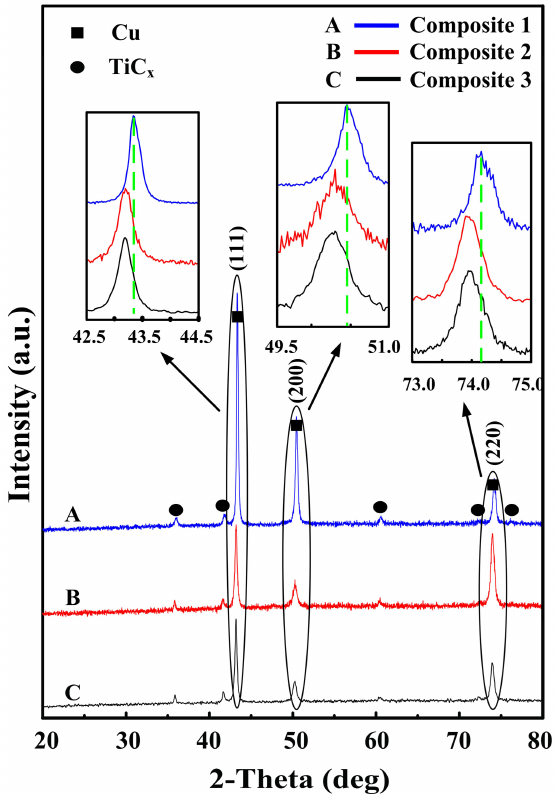
Figure 1. XRD patterns of composites 1, 2, and 3.